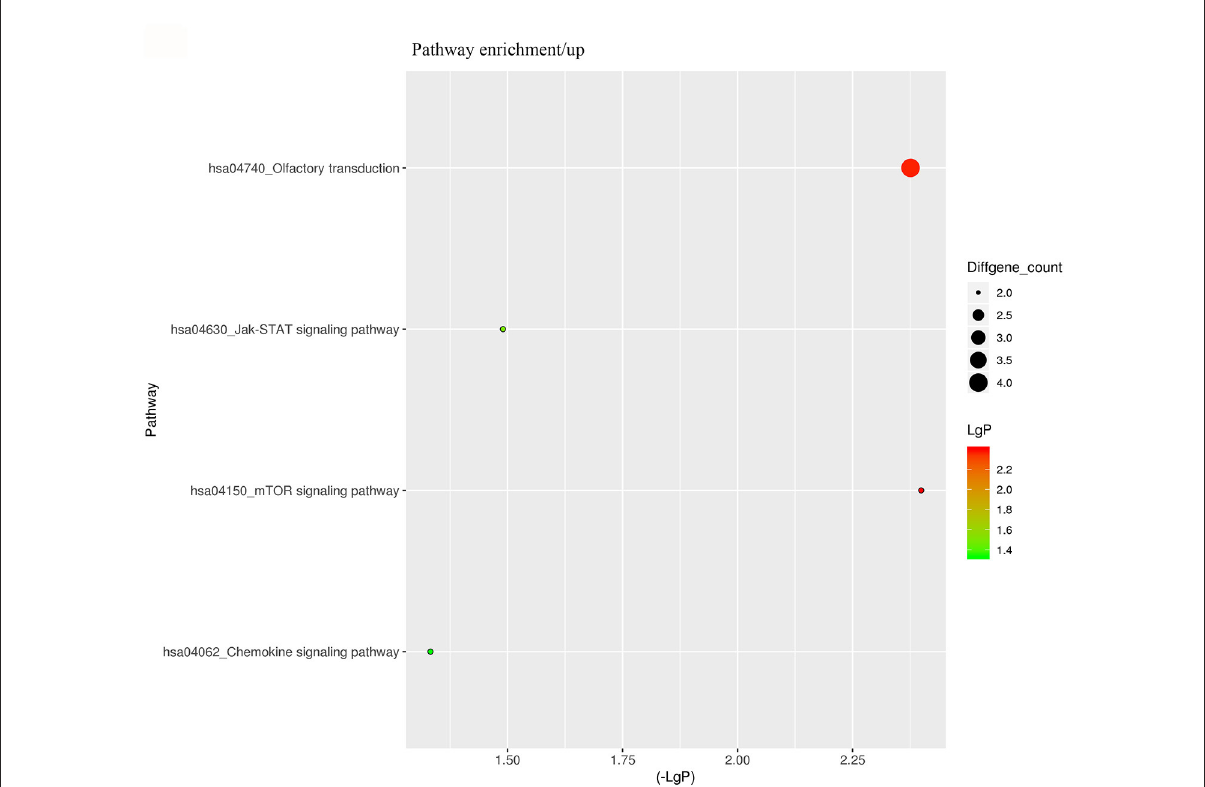
FIGURE5 KEGG Pathway analysis of differentially expressed genes based on the KEGG database. And KEGG pathways enrichments of up-regulated genes. The x-axis represents the negative logarithm of the p -value (-Lg P). The larger the value, the greater the significant difference of this pathway. The size of the bubble represents the number of differentially expressed genes in the